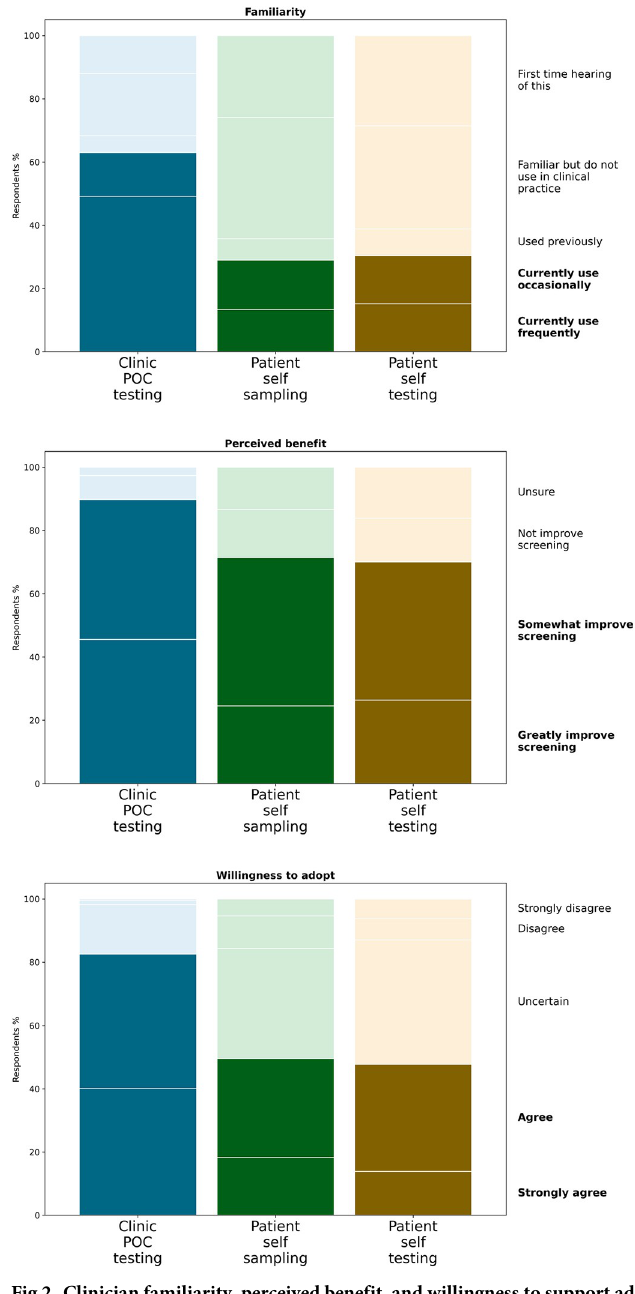
Fig 2. Clinician familiarity, perceived benefit, and willingness to support adoption of different cervical cancer screening modalities. For each testing modality (POC, self-sampling, self-testing) clinician familiarity, using a 5-point Likert scale from “This is my first time hearing about it” to “I currently use this frequently” (top); perceived benefit, on a 4-point scale ranging from ‘Would not improve’ to ‘Would greatly improve’ (center); and willingness to adopt, on a 5-point Likert scale from “strongly agree” to “strongly disagree” (bottom) is